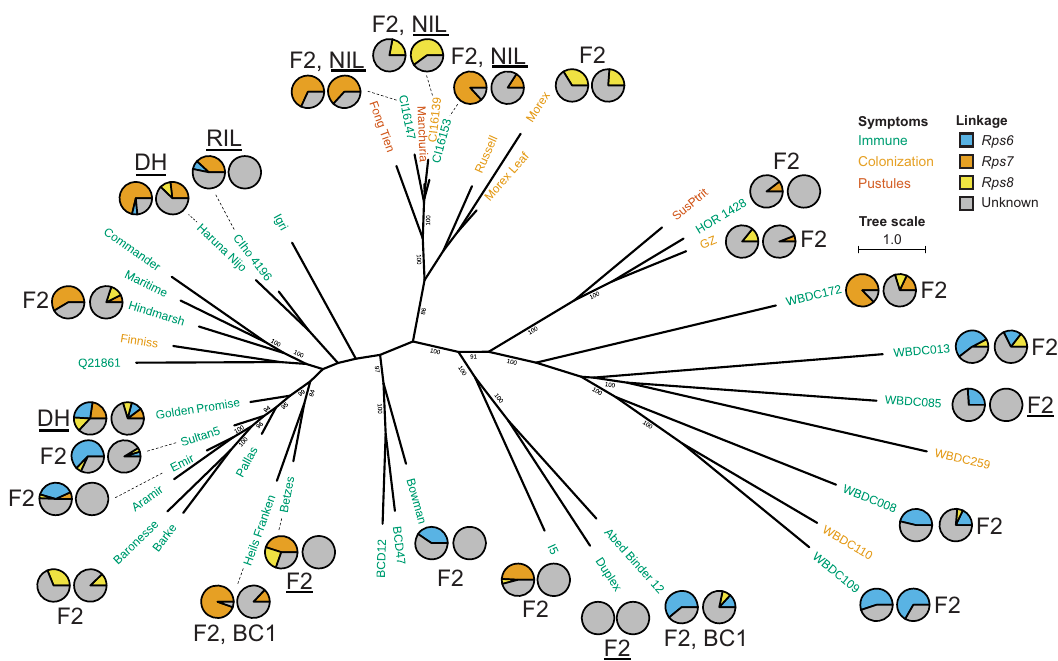
Fig. 2 Rps6 , Rps7 , and Rps8 are present throughout diverse barley accessions. Phylogenetic tree was generated with maximum likelihood based on SNP calling using leaf RNAseq derived from 41 genotypes. A control included RNAseq from Morex leaf. A total of 19,429 polymorphic sites were used for construction of the tree. Support over 80% is shown at branch points in the phylogeny based on 1,000 bootstraps. Scale indicates number of nucleotide substitutions. Coloring of genotypes is based on their reaction to P . striiformis f. sp. tritici isolate 08/21: immunity (green), colonization (yellow), and pustule formation (dark orange). Pie charts represent percent variation explained (PVE) for signi fi cant marker-trait associations (Supplementary Data 2, 3, 4). Two pie charts are shown for each population analyzed using two microscopic phenotypes, with the left and right chart representing percent colonization